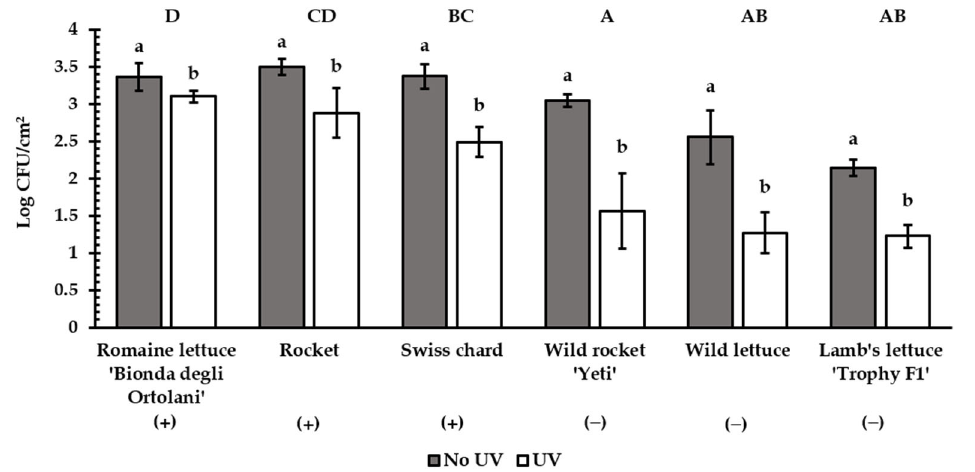
Figure 4. Correlation between E. coli ATCC 35218 attachment and ( A , B ) roughness (Ra and Rq) and ( C ) leaf water content % in the six selected accessions. * Significant per p < 0.05; ** significant per p < 0.01.